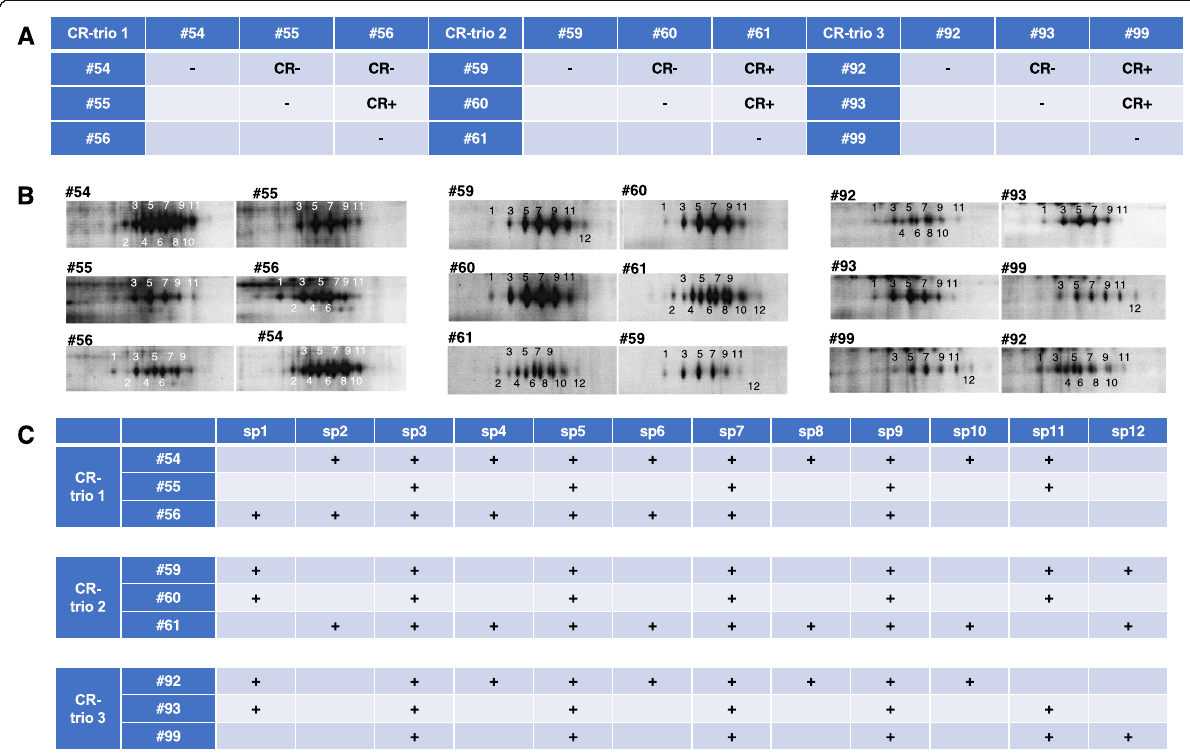
Fig. 5 2D-differential gel electrophoresis (DIGE) of H. roretzi hemocytes using three CR-trios. ( a ) CR patterns between the different members of the H. roretzi CR-trios. ( b ) Gel section corresponding to the region encompassing 7.0 – 8.0 pI and 100 kDa of hemocyte proteins isolated from the individuals shown in a . Protein samples labeled with Cy3 ( left ) and Cy5 ( right ). c Summary of the 100-kDa protein isoforms (spots) found in each of the individuals (from b ). Each of the 12 spots was classified by normalization with three 49 kDa protein spots (labeled with yellow triangles